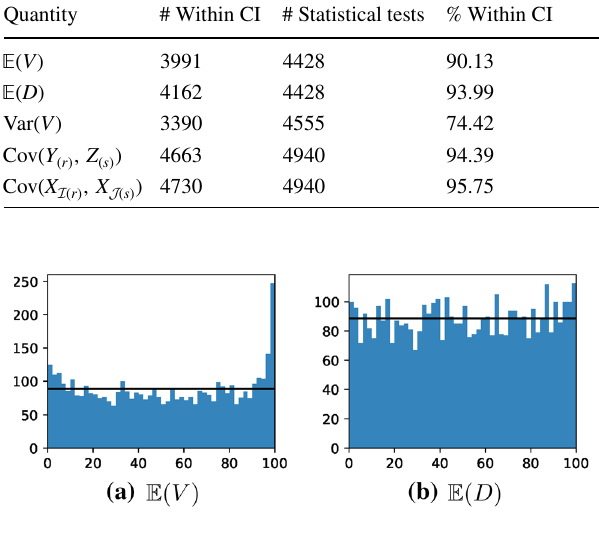
8 The estimation noise ( 𝜎 2 𝜖 ) from an A/B test measuring conversion rate (CVR) uplift is the variance of the distribution on the difference in CVR between two variants under a no-difference null hypothesis. with n